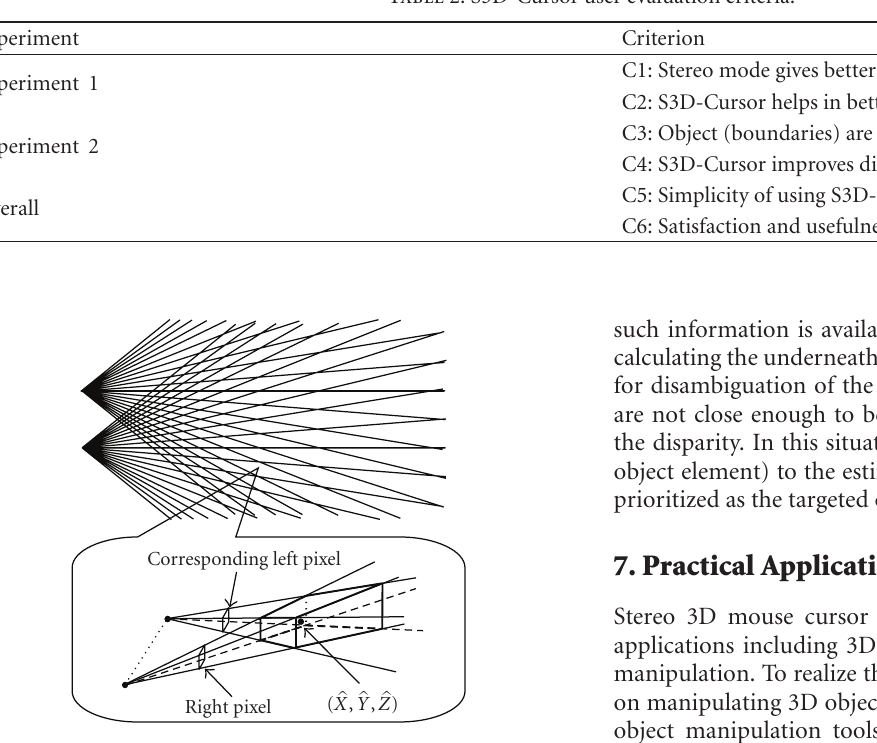
Figure 5: Top: Resolution pattern for parallel-stereo geometry. Bottom: 3D view of a typical voxel formed by two corresponding